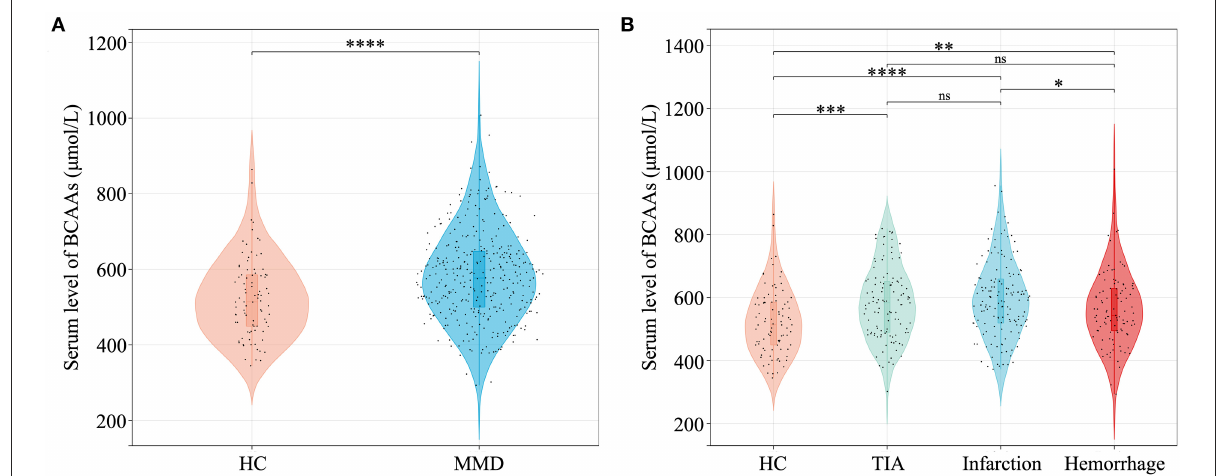
FIGURE2 Quantitative analysis of serum BCAAs level between MMD patients and HCs. (A) Comparison of BCAAs level between HCs and MMD patients. (B) Comparison of BCAAs level between HCs and MMD subtypes. BCAAs, branched-chain amino acids; HC, healthy control; MMD, moyamoya disease; TIA, transient ischemic attack; ns, not significant. * P < 0.05; ** P < 0.01; *** P < 0.001; **** P <